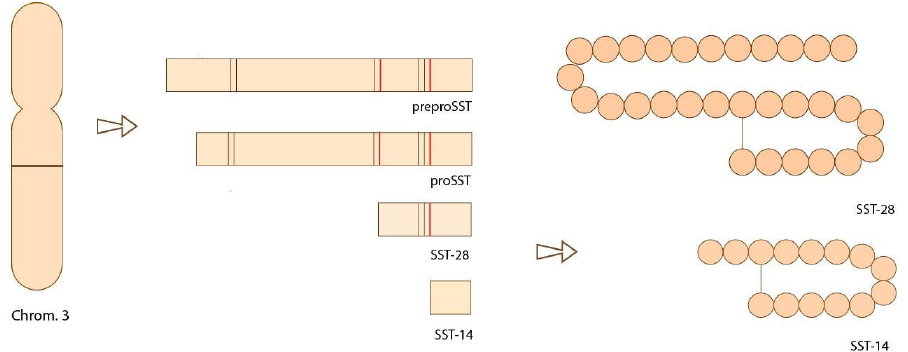
Figure 1. Representation of the location of the gene that codes for SST on chromosome three. DNA is transcribed into RNA and then translated to produce the peptide “pre-proSST”. It is cleaved enzymatically at locations indicated in red, producing isoforms SST-14 and SST-28 [5].